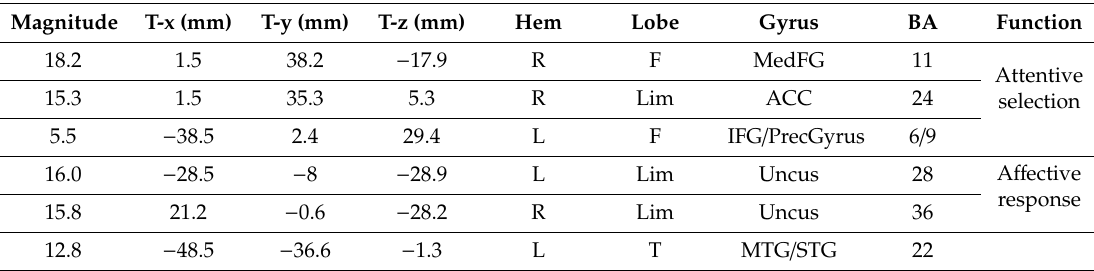
Table 1. List of estimated electromagnetic